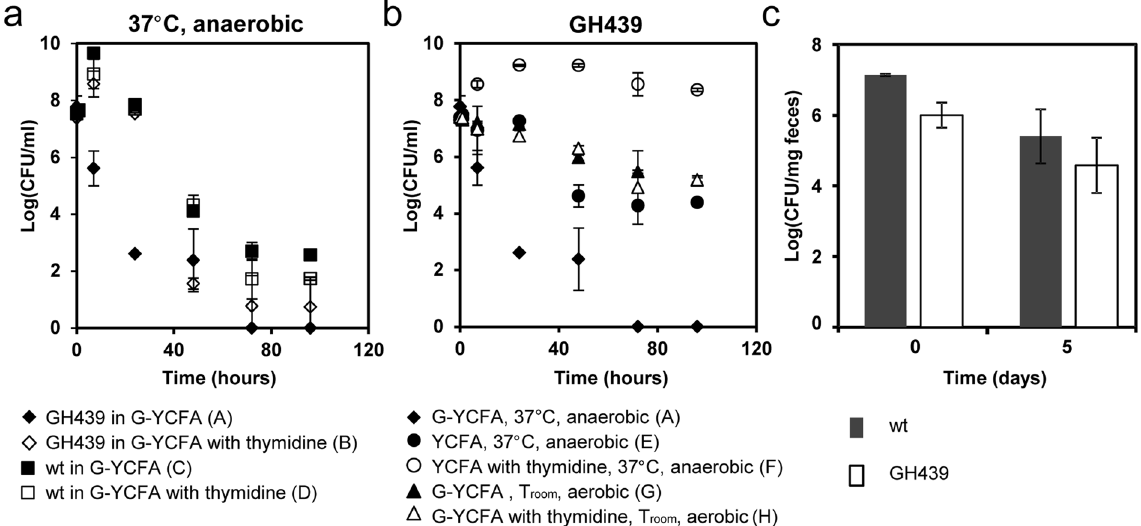
Figure 3. Growth and survival of B . ovatus wt and GH439 strains. ( a ) Growth and survival of wt and GH439 under optimal growing conditions with and without thymidine. ( b ) Growth and survival of GH439 under different environmental condition with and without thymidine. ( c ) Survival of wt and GH439 in mouse fecal samples prior to (0) and at 5 days post inoculation. In ( a , b ) data shown are representative of at least two independent experiments. In ( c ) values represent the mean of data from three independent experiments. Error bars indicate standard